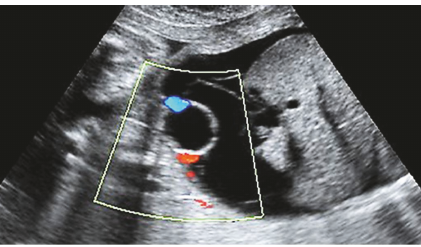
Figure 1: Ascites in the peritoneal cavity with the two umbilical arteries encircling the urinary